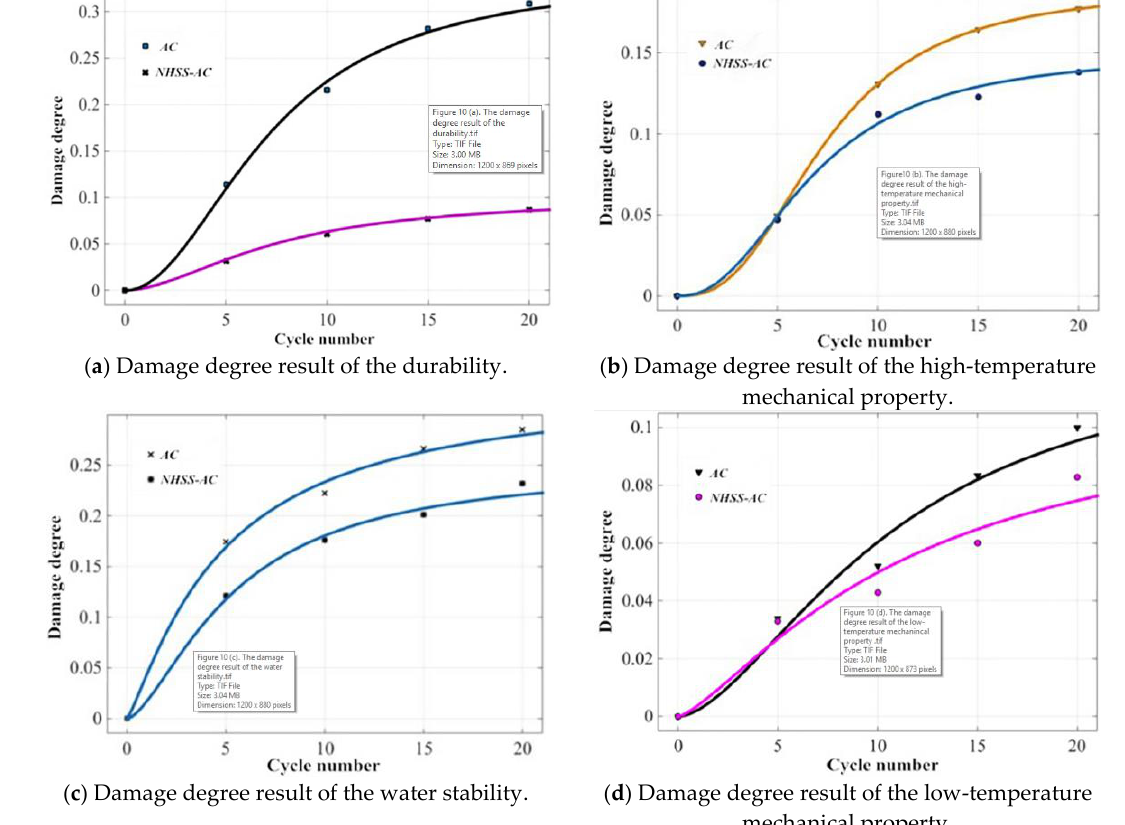
Figure 10. Damage degree result of the various properties of the AC and NHSS-AC.